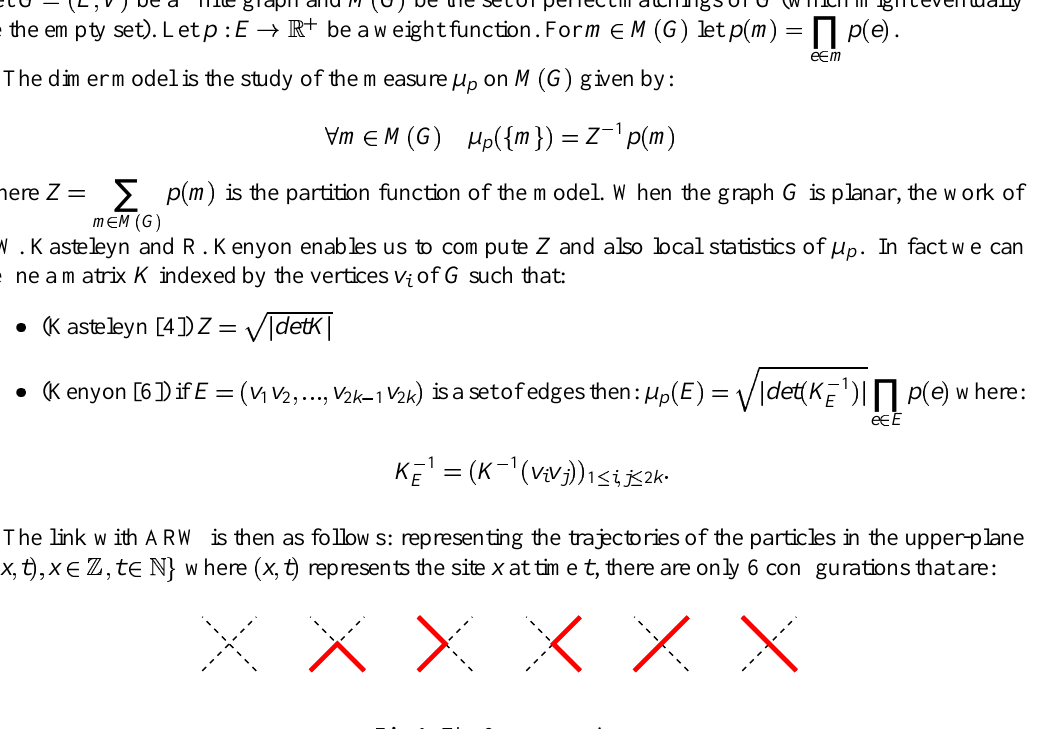
Fig. 1: The 6 configurations